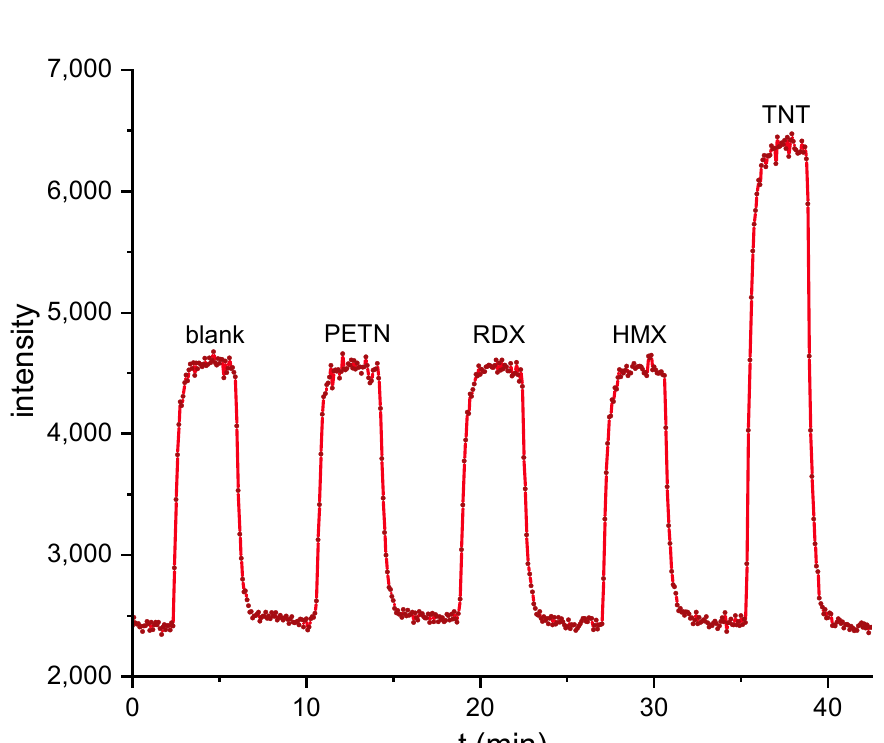
Figure 8. Biosensor-based cross-reactivity test for the high explosives pentaerythritol tetranitrate (PETN), 1,3,5-trinitroperhydro-1,3,5-triazine (RDX), octahydro-1,3,5,7-tetranitro-1,3,5,7-tetrazocine (HMX), and TNT at 5 nM. Only 2,4,6-trinitrotoluene (TNT) shows a positive signal.